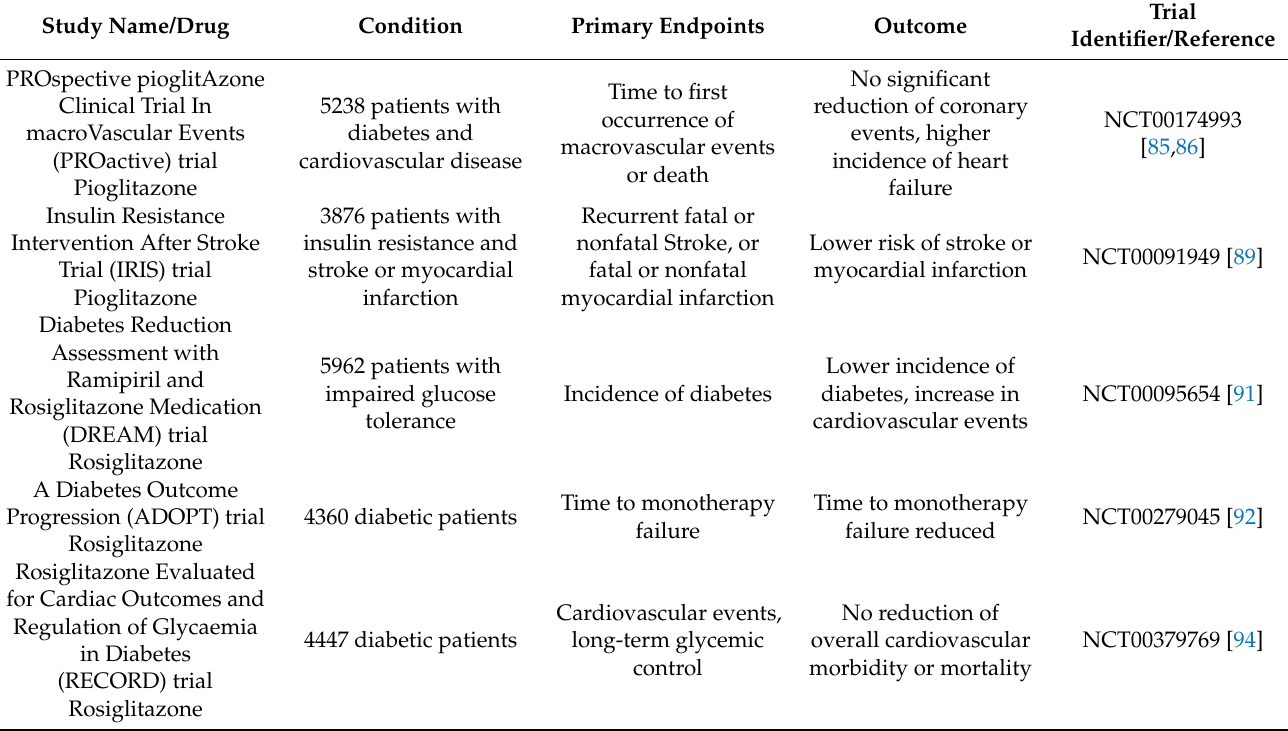
Table 2. Summary of Clinical Trials with PPAR γ agonists for Cardiovascular